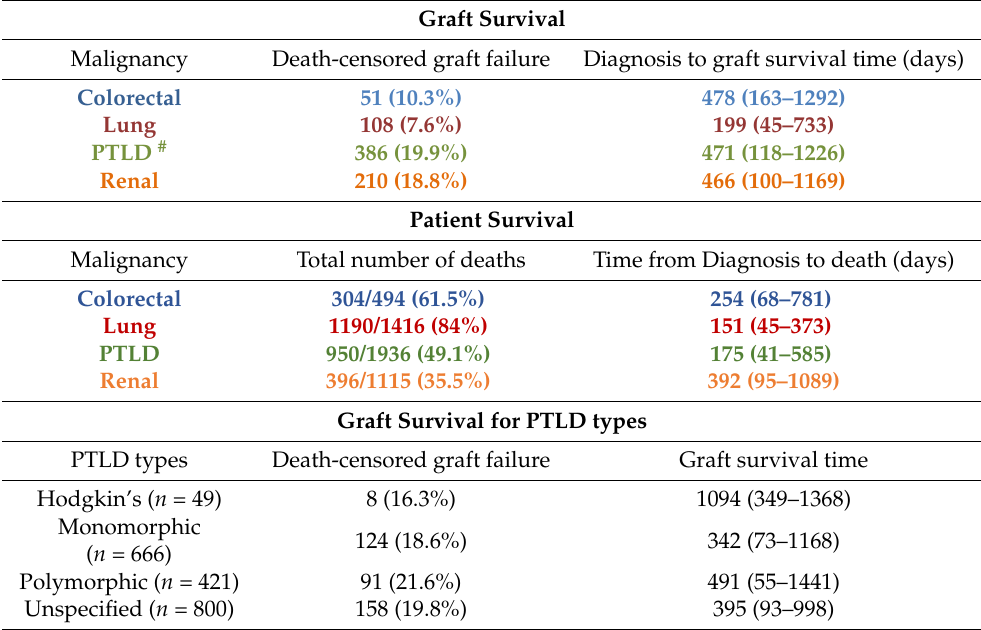
Table 3. Patient survival and death-censored graft survival after diagnosis of malignancy for each malignancy and types of